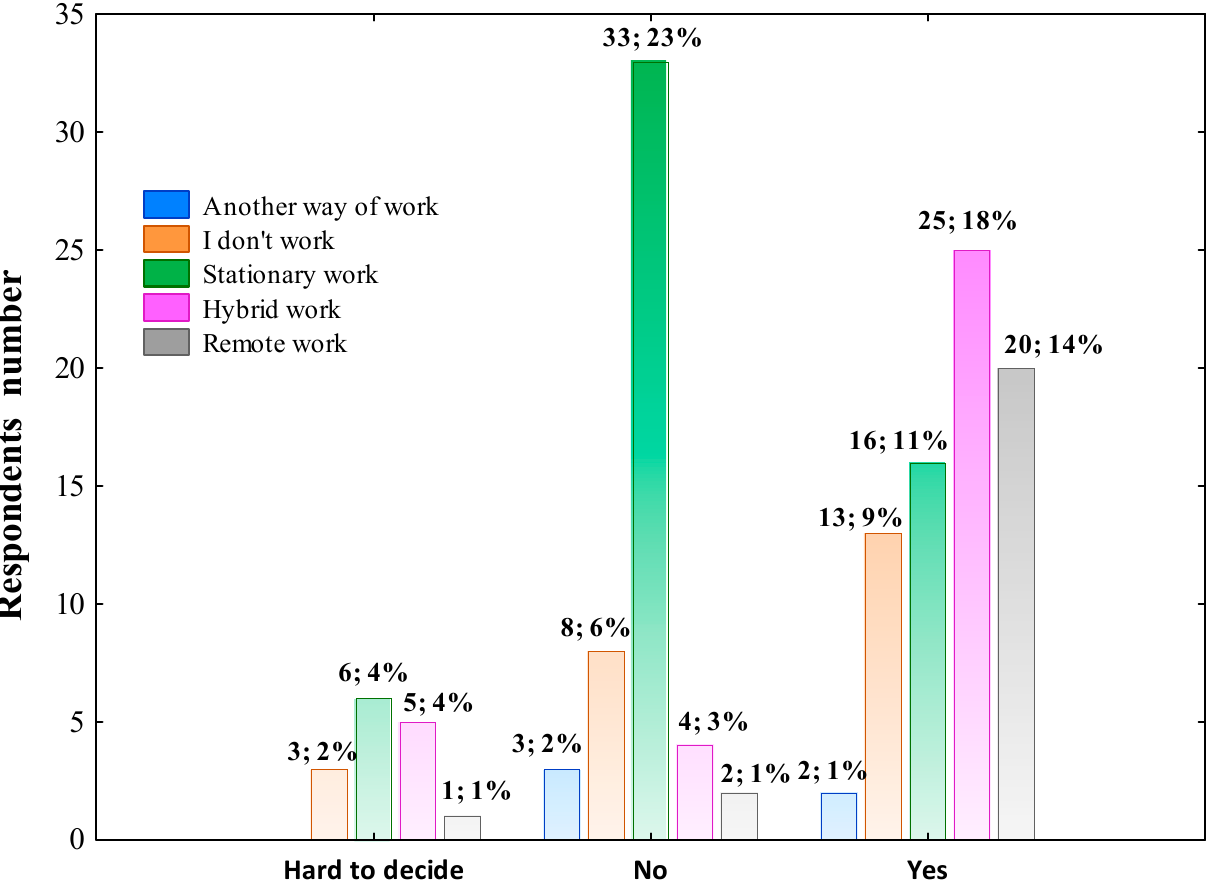
Figure 8. The effect of the COVID-19 pandemic on daily lifestyle change according to the professional work mode. The column description includes the respondents’ number who declared the effect or no effect of the pandemic on changing the daily lifestyle, followed by the percentage of the total respondents. Data were analyzed using Pearson’s chi-squared test. Pearson’s χ 2 = 35.800; df = 8; p = 0.00002; n = 145.